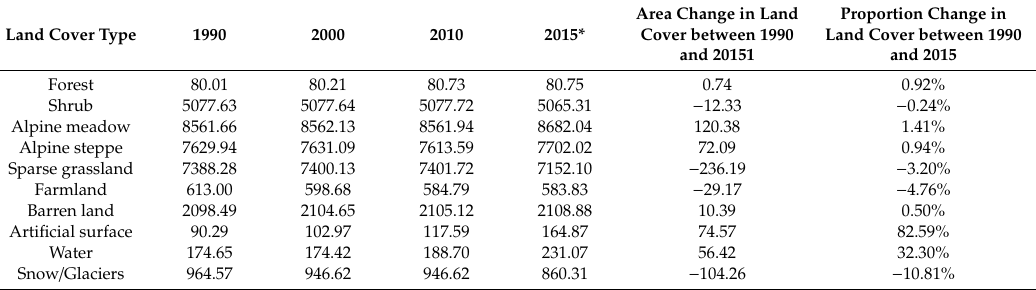
Table 3. Area of di ff erent land cover types and changing rate in the Lhasa River Basin from 1990 to 2015 (Unit: km 2 ).